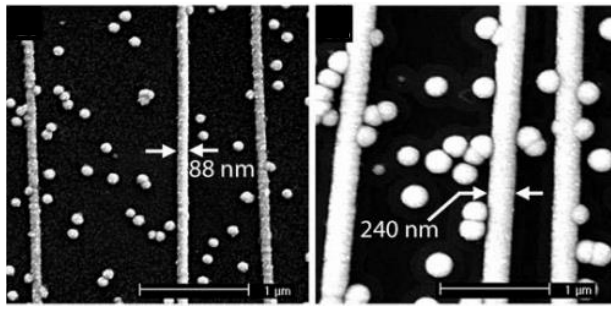
Figure 4. MoS 2 nanowires/nanoribbons synthesized from MoO x precursor [43] .